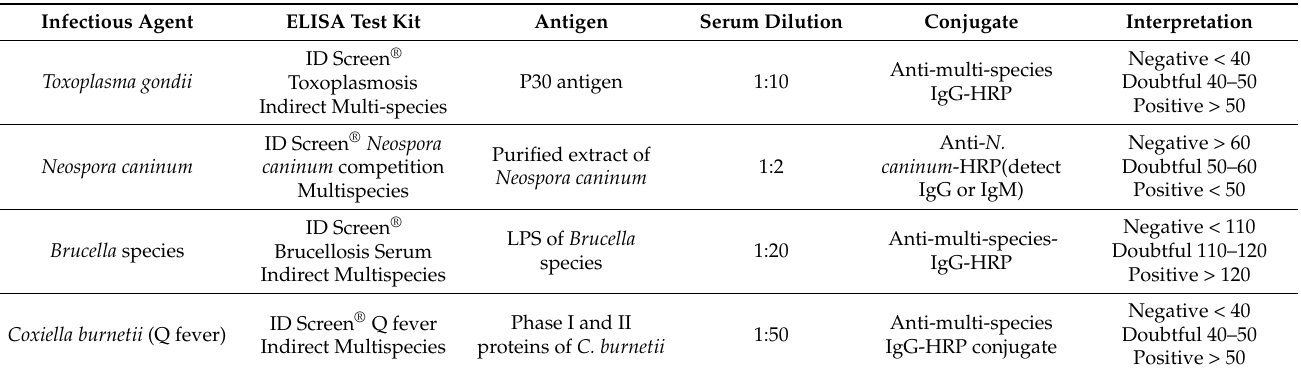
Table 1. Commercially available ELISA test kits used for detecting antibodies to T. gondii , N. caninum , Brucella spp., and Q